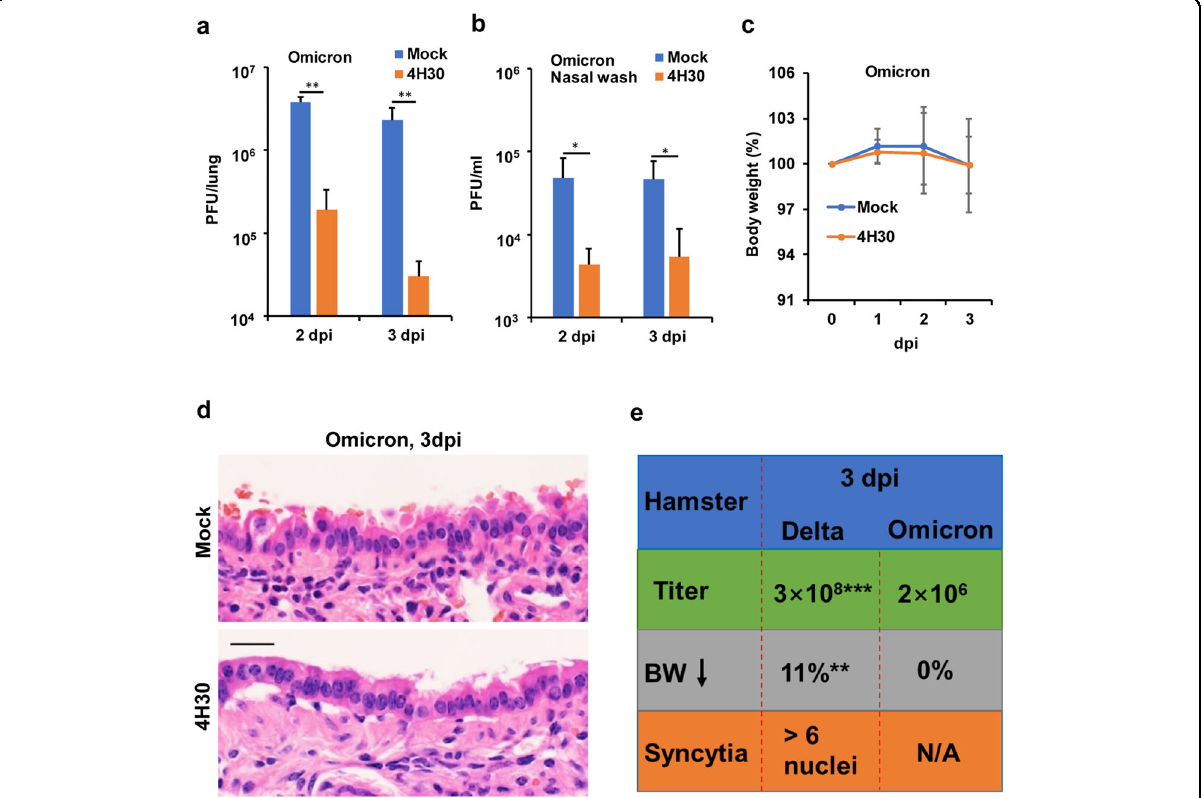
Fig. 5 4H30 signi fi cantly inhibited Omicron variant (B.1.1.529) replication in hamsters. a 4H30 inhibited the replication of Omicron variant in hamster lungs at 2 dpi ( n = 3) and 3 dpi ( n = 4). b 4H30 inhibited the replication of the Omicron variant in the nasal cavity. Viral titers in the